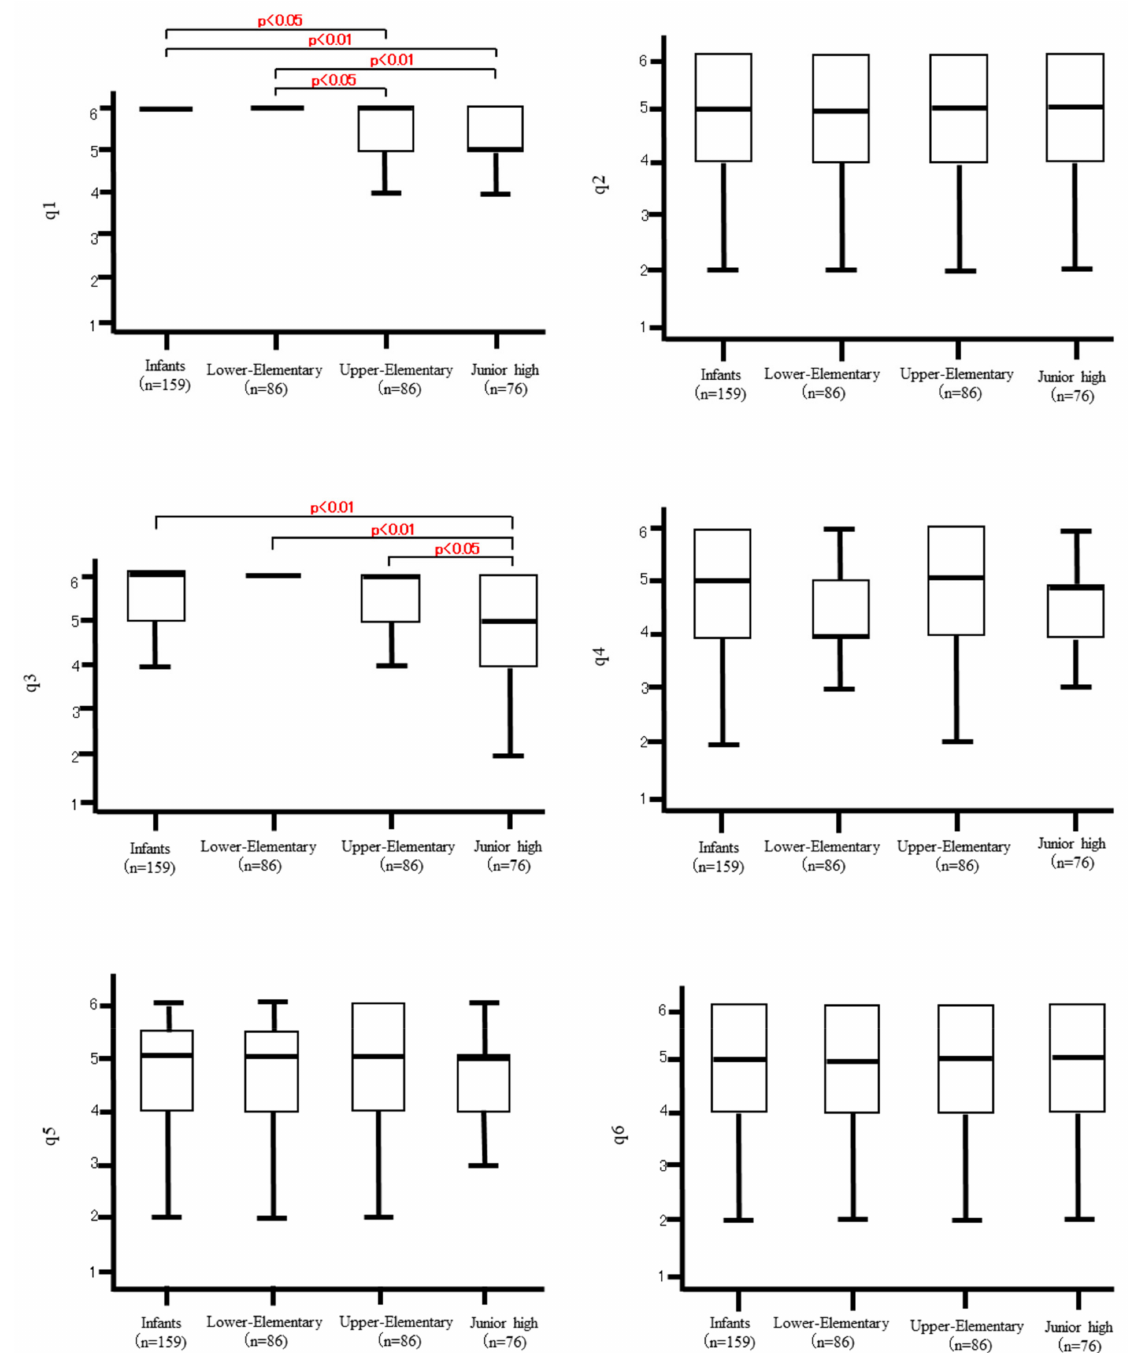
Figure 2. Effects of the stage of child development on the